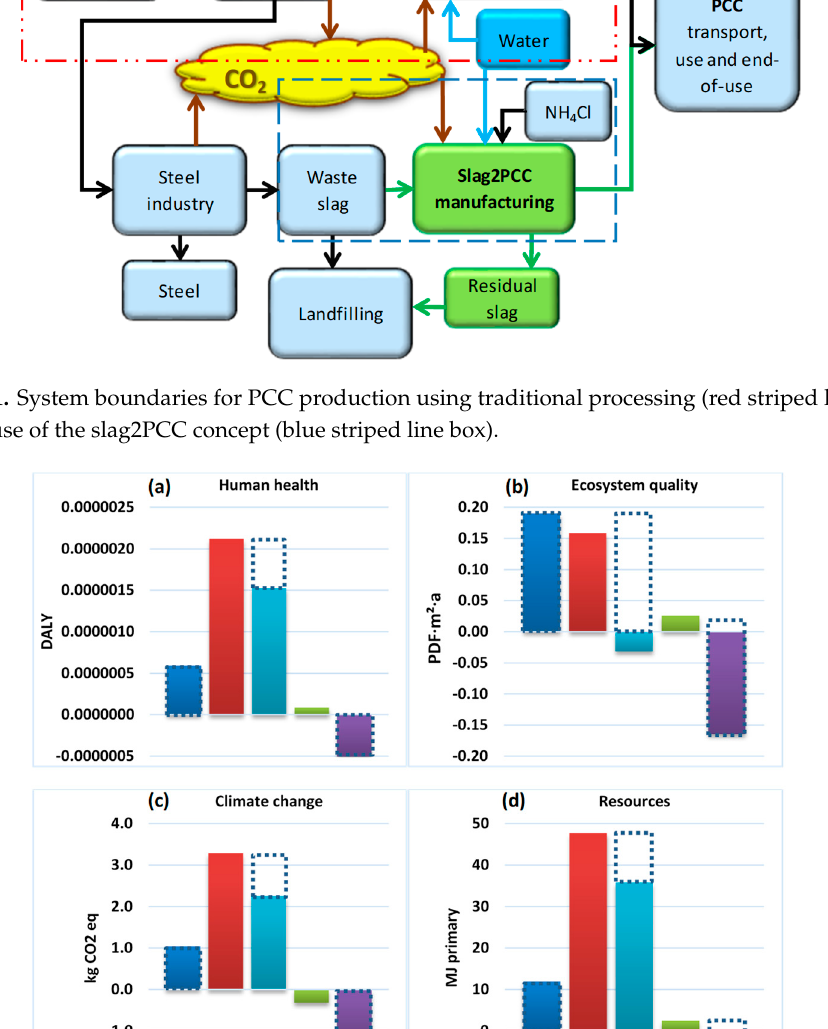
Figure 12. Life cycle assessment (LCA) results for PCC production using a traditional method versus the use of the slag2PCC concept at different solvent concentrations and/or as a system expansion concept (see the text) for four impact categories: Human health ( a ), Ecosystem quality ( b ), Climate change ( c ), Resources ( d ) DALY: disability adjusted life years. PDF ∙ m 2 ∙ a: potentially disappeared fraction of species times area and time.